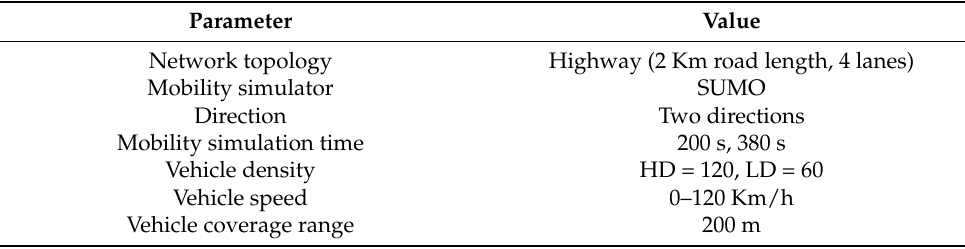
Table 5. Simulation parameters .